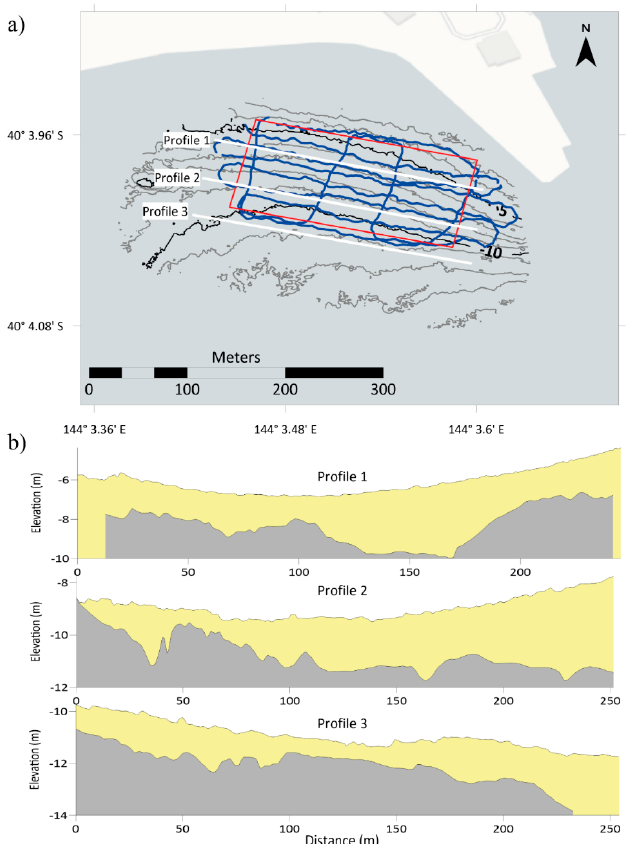
Figure 4. ( a ) Map shows the sub-bottom coverage within the candidate site (along the blue vessel track line and the position of three transects that were interpolated from high-resolution coverage of the area). ( b ) Bottom panel shows the interpolated cross sections demonstrating the sand layer thickness in the survey area. Yellow shading reflects sand layer and the gray shades the underlying bedrock.